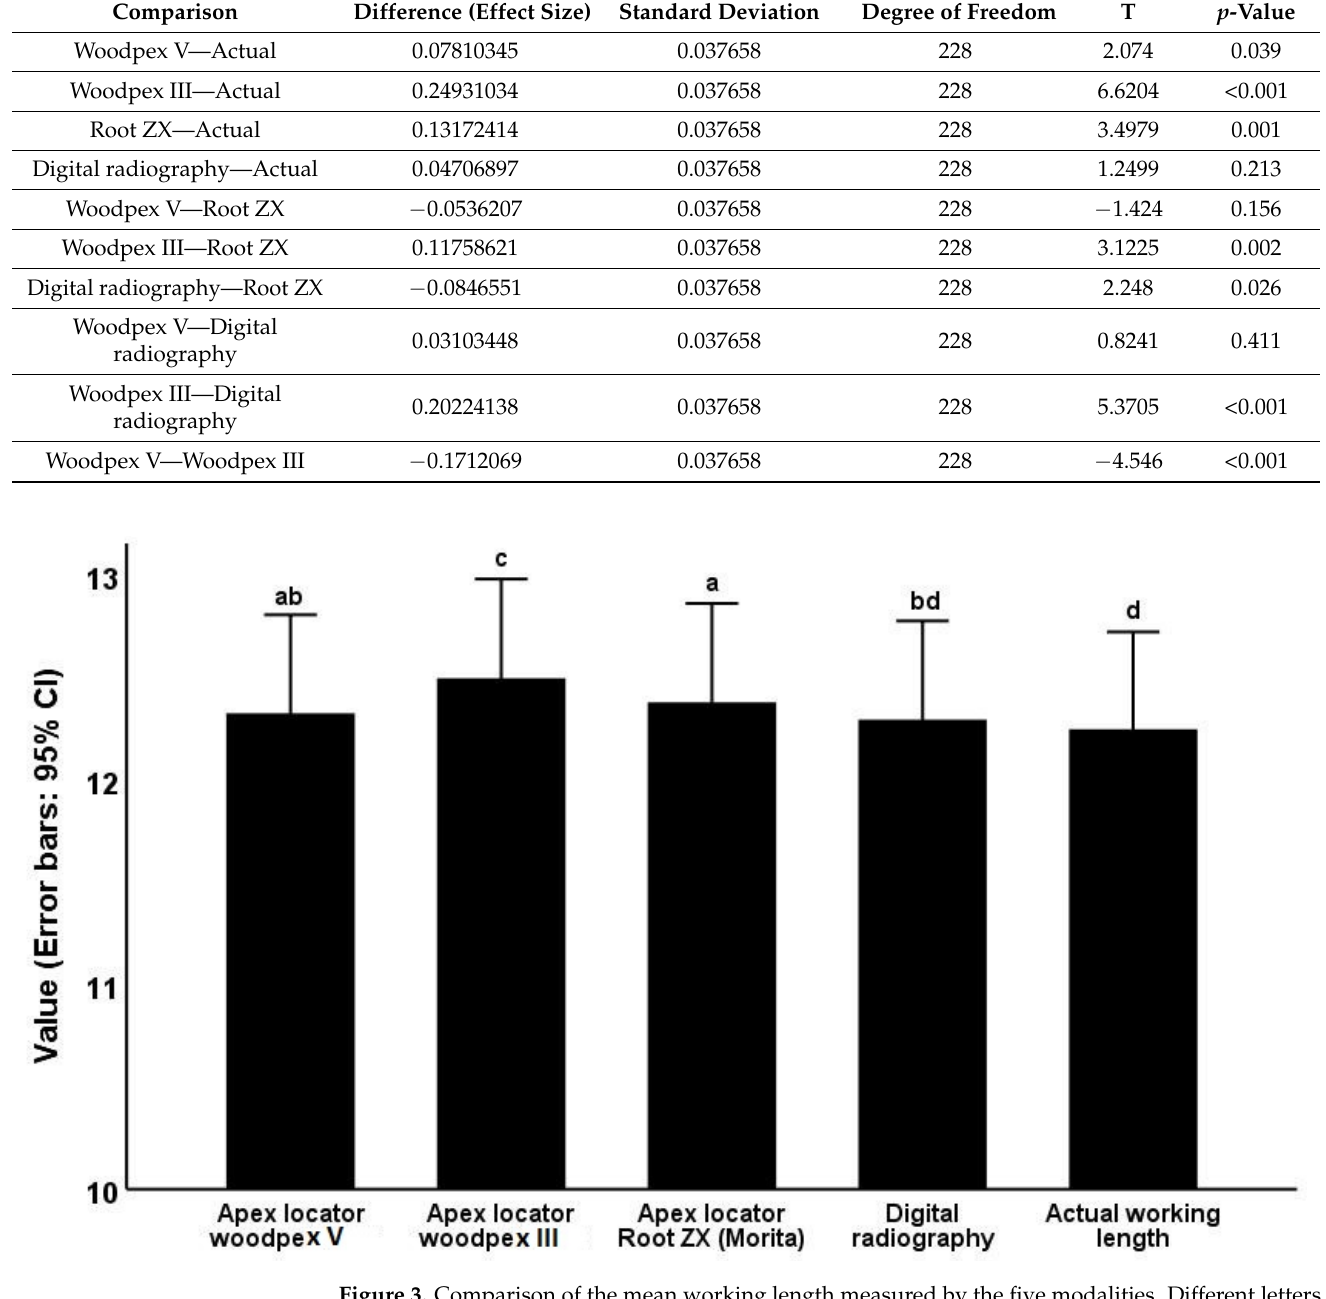
Figure 3. Comparison of the mean working length measured by the five modalities. Different letters for each pair of the groups represent a significant difference between them ( p < 0.05). Table 3 presents the effect of position of the apical foramen (central/lateral) on the accuracy of WL measurement by different instruments. The position of the apical foramen had no significant effect on the accuracy of WL measurement by different instruments ( p > 0.05).